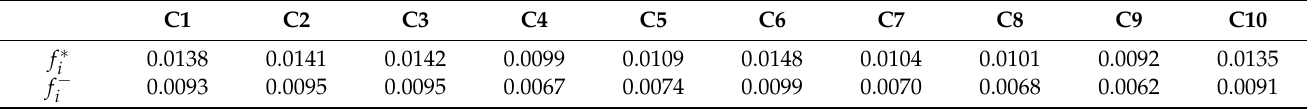
Table 17. Positive ideal solution and negative ideal solution of each big data analysis enabler.